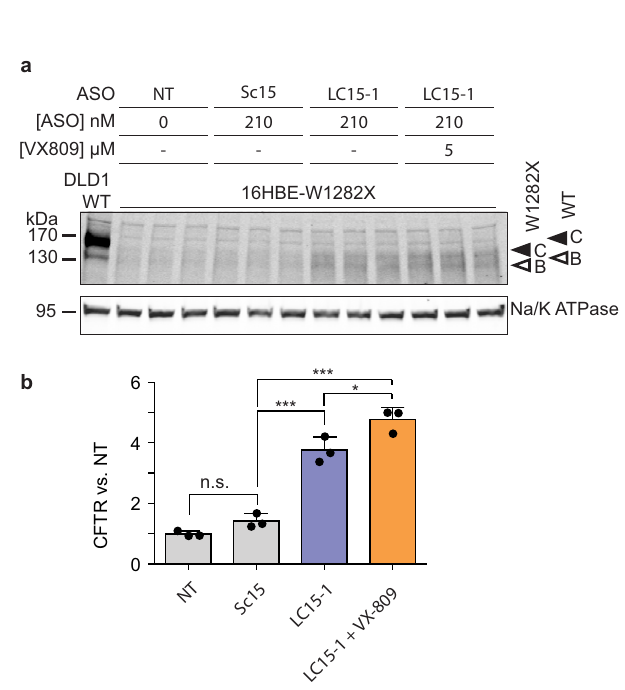
Fig. 3 Effect of the lead ASO cocktail on CFTR-W1282X protein expression. a Western blot of CFTR-W1282X protein in 16HBE-W1282X cells transfected with Sc15 or LC15-1 and treated with VX-809 at the indicated concentrations. The closed and open arrowheads indicate C and B bands of CFTR proteins, respectively. b Quanti fi cation of total CFTR protein in ( a ). Abbreviations as in Fig. 1. Data are represented as mean values ± SD. All data points represent independent biological replicates. n = 3, n.s. P > 0.05, * P < 0.05, ** P < 0.01, *** P < 0.001, one-way ANOVA with Tukey ’ s post-test. Source data are provided as a Source Data